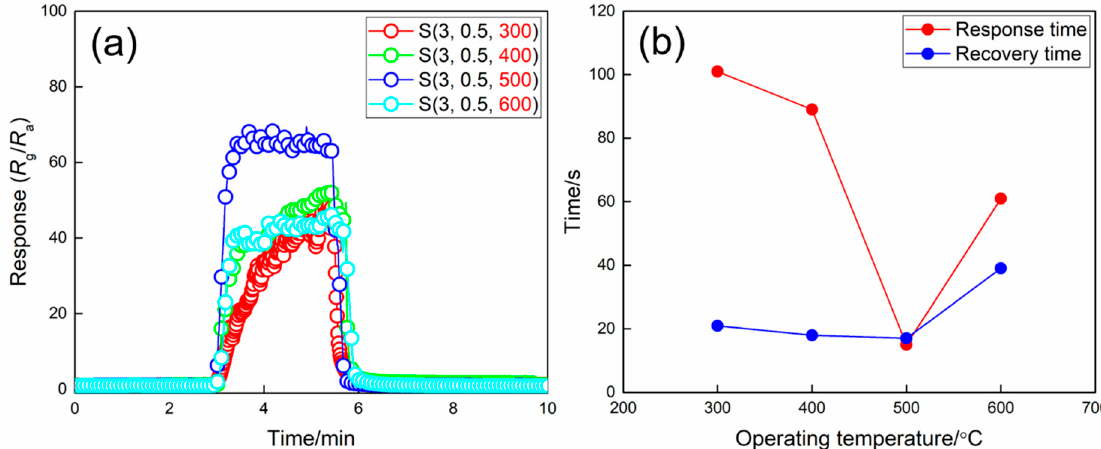
Figure 10. ( a ) Dynamic response/recovery curves and ( b ) response/recovery times of WO 3 films prepared at different calcination temperatures upon exposure to 5 ppm NO 2 at 100 °C.